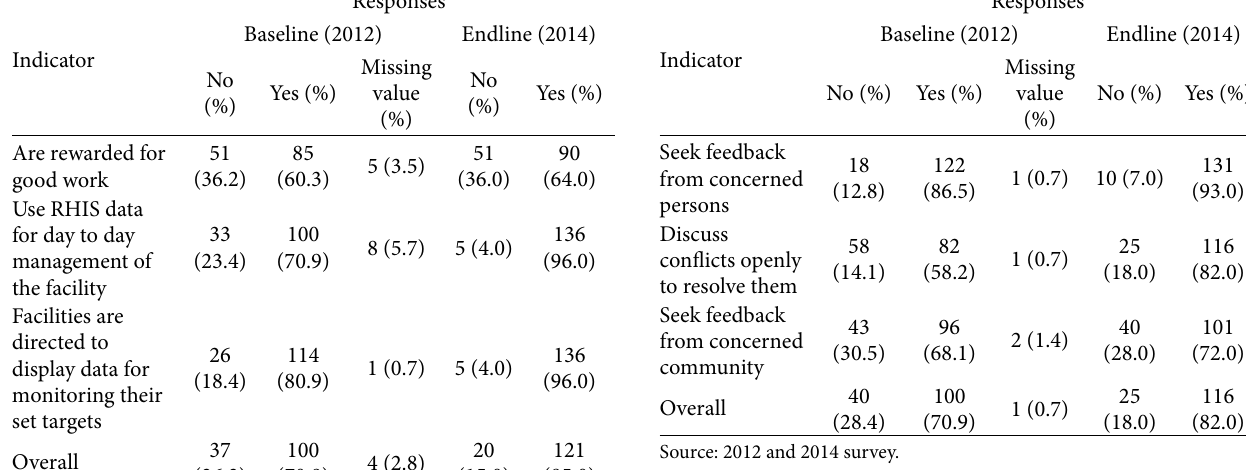
Table 3: Promotion of